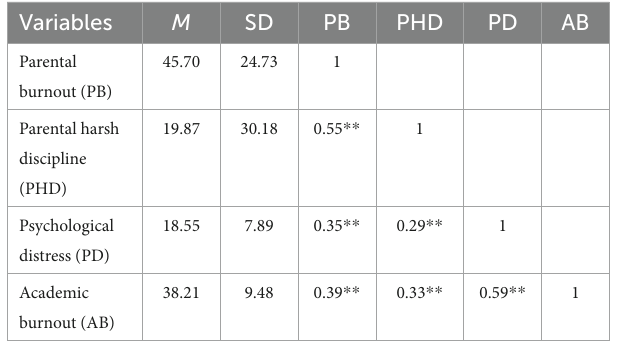
TABLE 1 Bivariate correlations ( N =